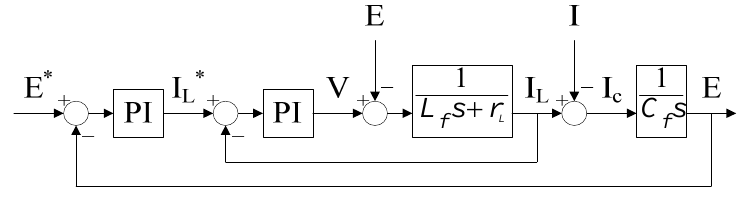
Figure 11. Block diagram for simplified voltage control.